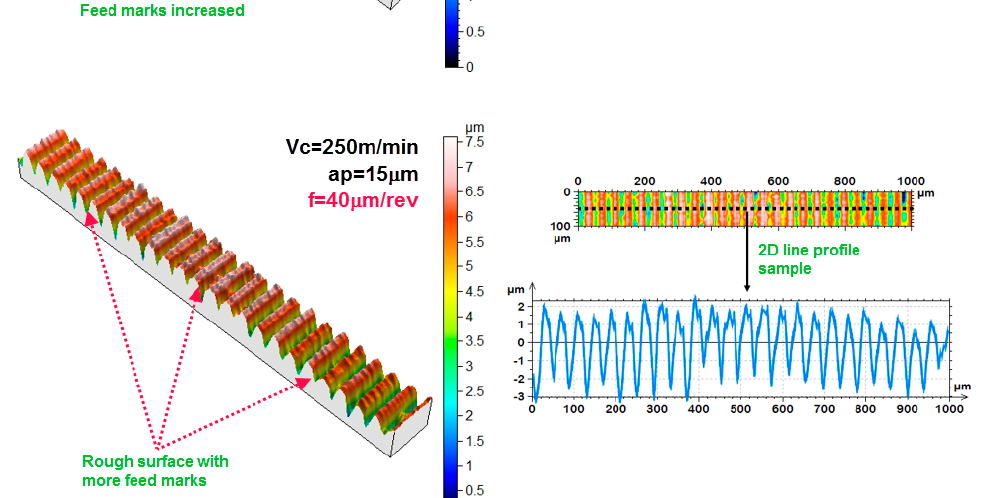
Figure 11. Influence of feed rate on surface 2D and 3D surface profiles.